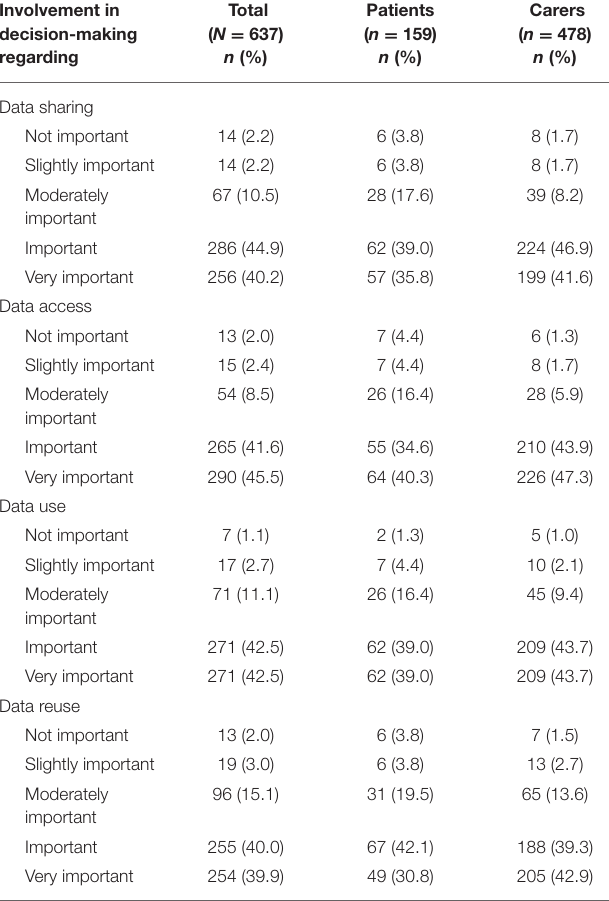
TABLE 2 | Participants’ views about involvement in decision-making regarding health data sharing, access, use and